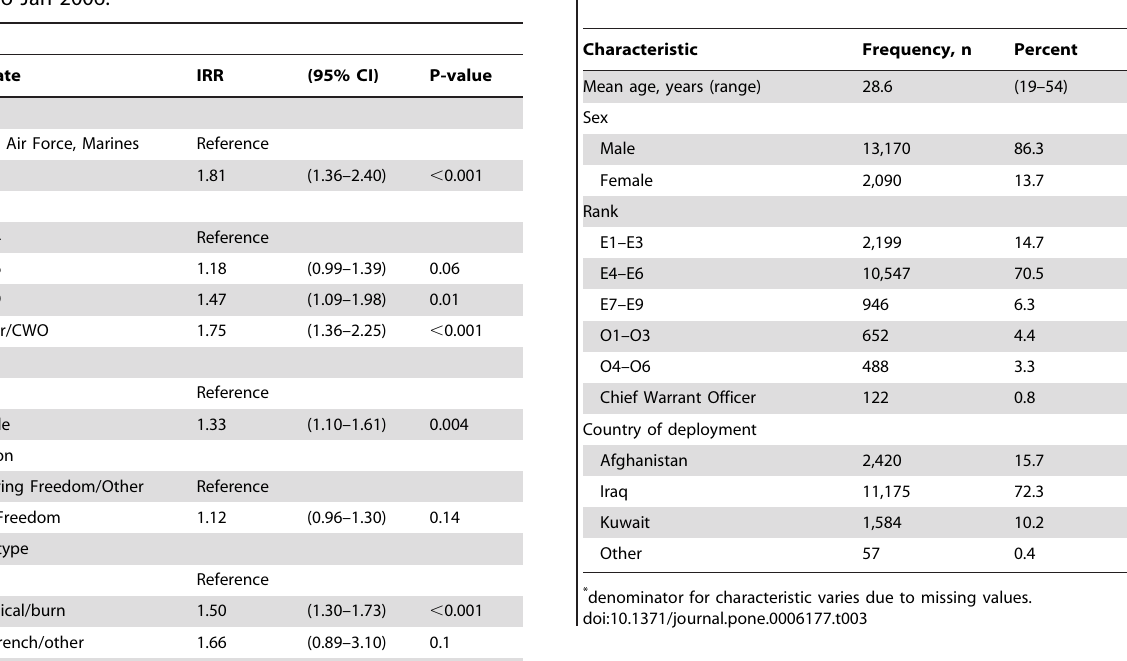
Table 3. Demographic characteristics of deployed